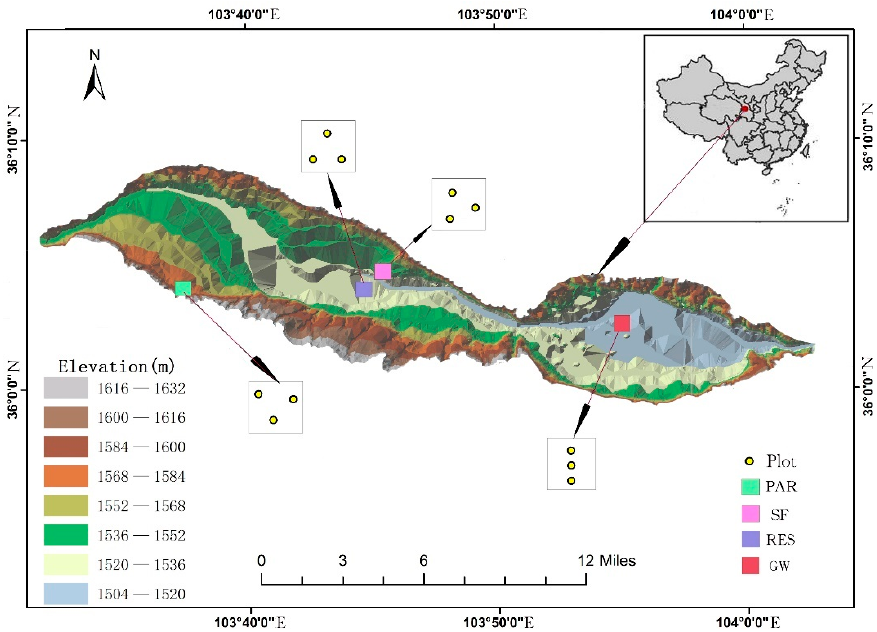
Figure 1. Distribution of sampling sites and plots in built-up area of Lanzhou city.